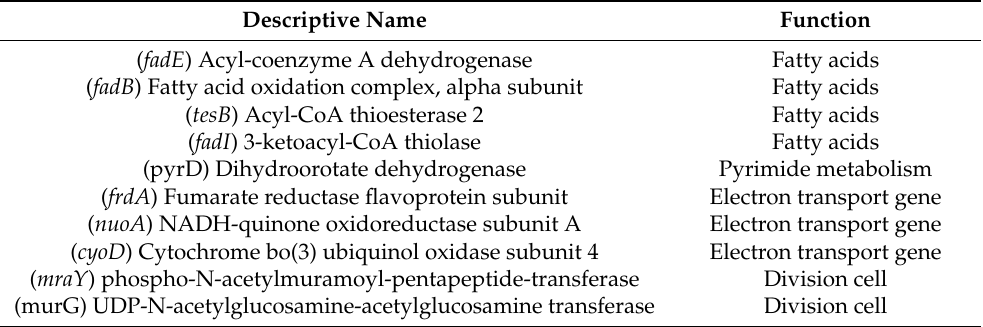
Table 4. List of genes sensitive to oxygen variation obtained through shadow prices